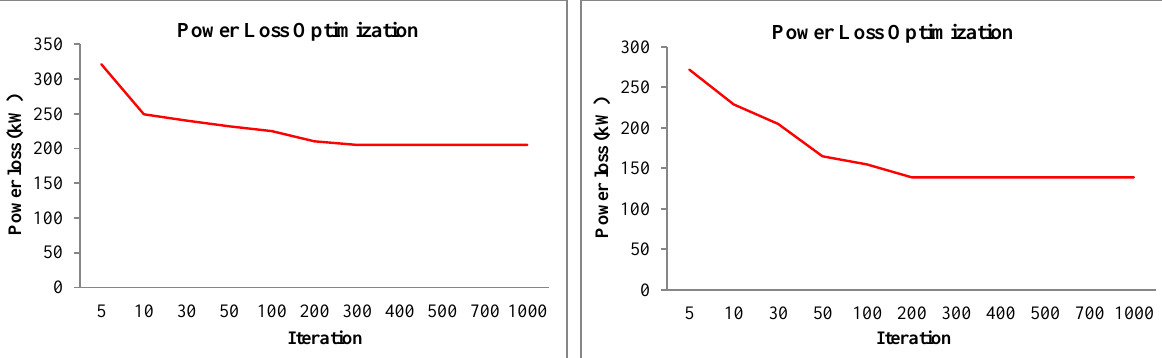
Figure 12. Power loss change to iteration during optimization of IEEE model distribution network 71-bus with four SGs; (a) original network optimized, and (b) SG installed network